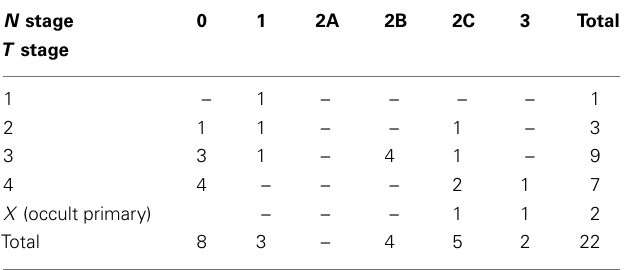
Table 4 | Summary ofTNM distribution.